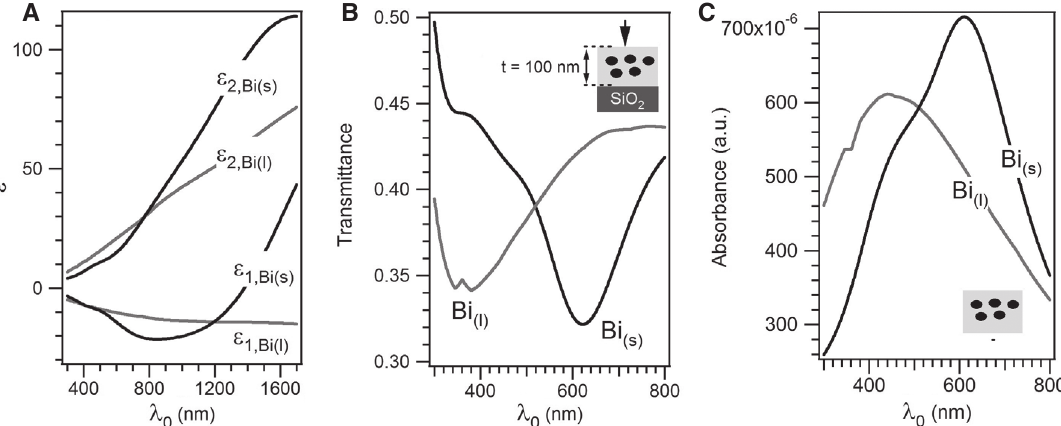
Figure 4 Optical contrast based on the solid-liquid transition of Bi NPs. (A) Real and imaginary part of solid Bi (taken from [66]) and of liquid Bi (interpolated from data taken from [74]). (B) Simulated transmittance spectra (at normal incidence) of a 100-nm-thick film consist- ing of solid Bi NPs (black line) and liquid Bi NPs (gray line) having the dielectric functions shown in (A), and being embedded in a trans- parent dielectric matrix described by a Cauchy law with parameters An = 2.5, Bn = 0.01. The effective in-plane properties of the film were calculated using the extension of the Maxwell-Garnett model to spheroidal NPs with their revolution axis perpendicular to the film surface. The transmittance was derived from the obtained effective dielectric function in the Abelés matrix formalism. The NPs were assumed to be = 0.2), and a low volume fraction f = 5%. The substrate spheroidal, with an oblate shape (H/D ∼ 0.46, i.e., an in-plane depolarization factor L xy is transparent SiO . This figure exemplifies the consequence of the phase transition on the optical response of the sample. (C) Calculated 2 absorbance α = 4 π k / λ , k being the effective in-plane extinction coefficient of the film, showing that the phase transition affects mainly eff 0 eff the optical